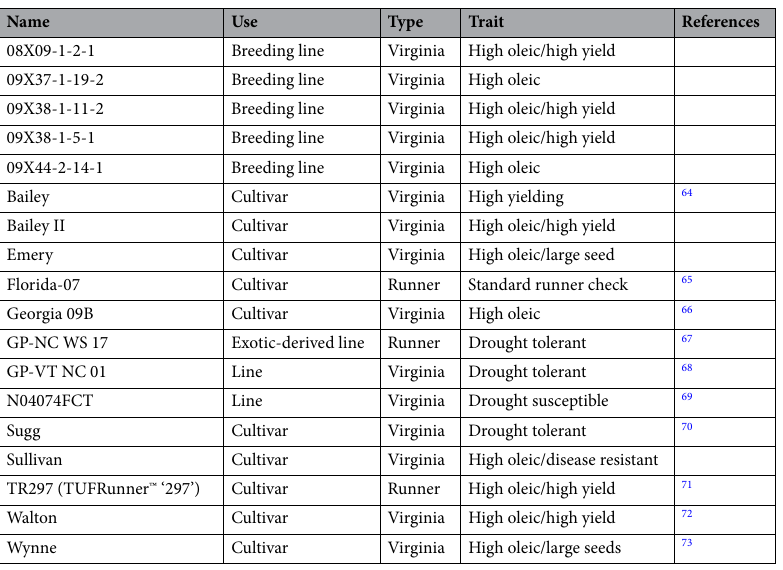
Table 1. Genotypes planted in study 1 to estimate the LAI from leaf